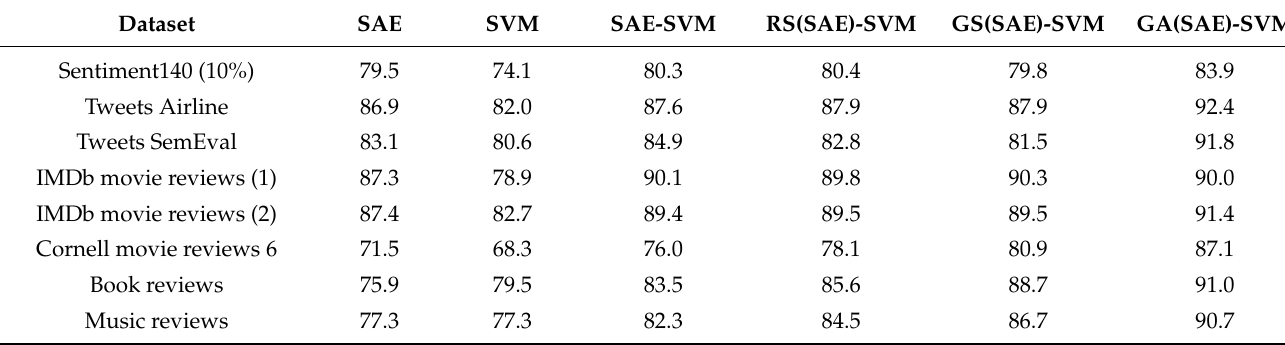
Table 10. F1-score comparison for different types of